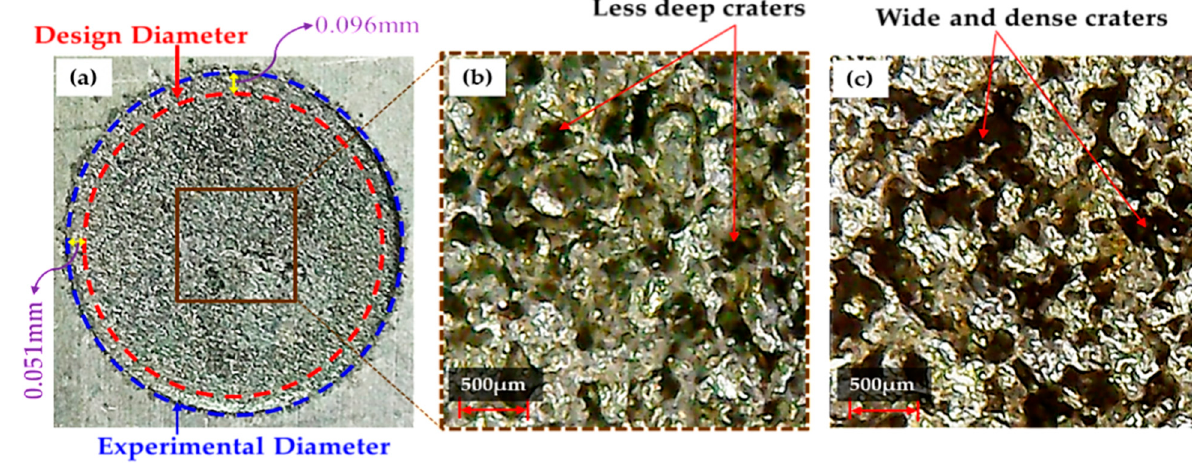
Figure 14. Experimental results obtained for the Cu-tool: ( a ) actual machined surface of workpiece showing minimum value of overcut; ( b ) micrograph showing less craters on the surface of the workpiece; ( c ) surface of the Cu tool representing wide and dense craters.